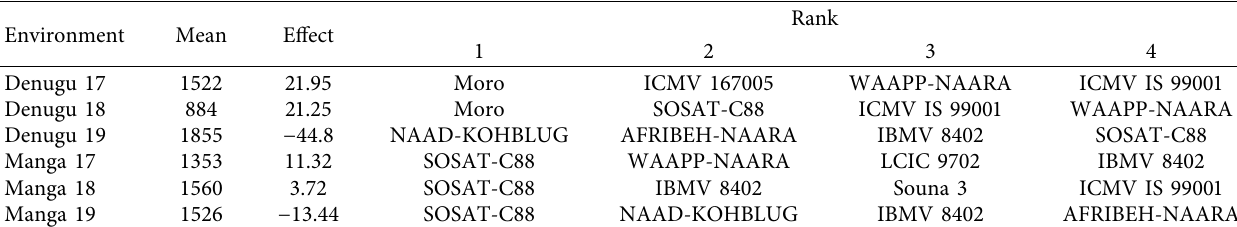
Table 9: First four AMMI selections of the best mean grain yielding OPVs in each environment.